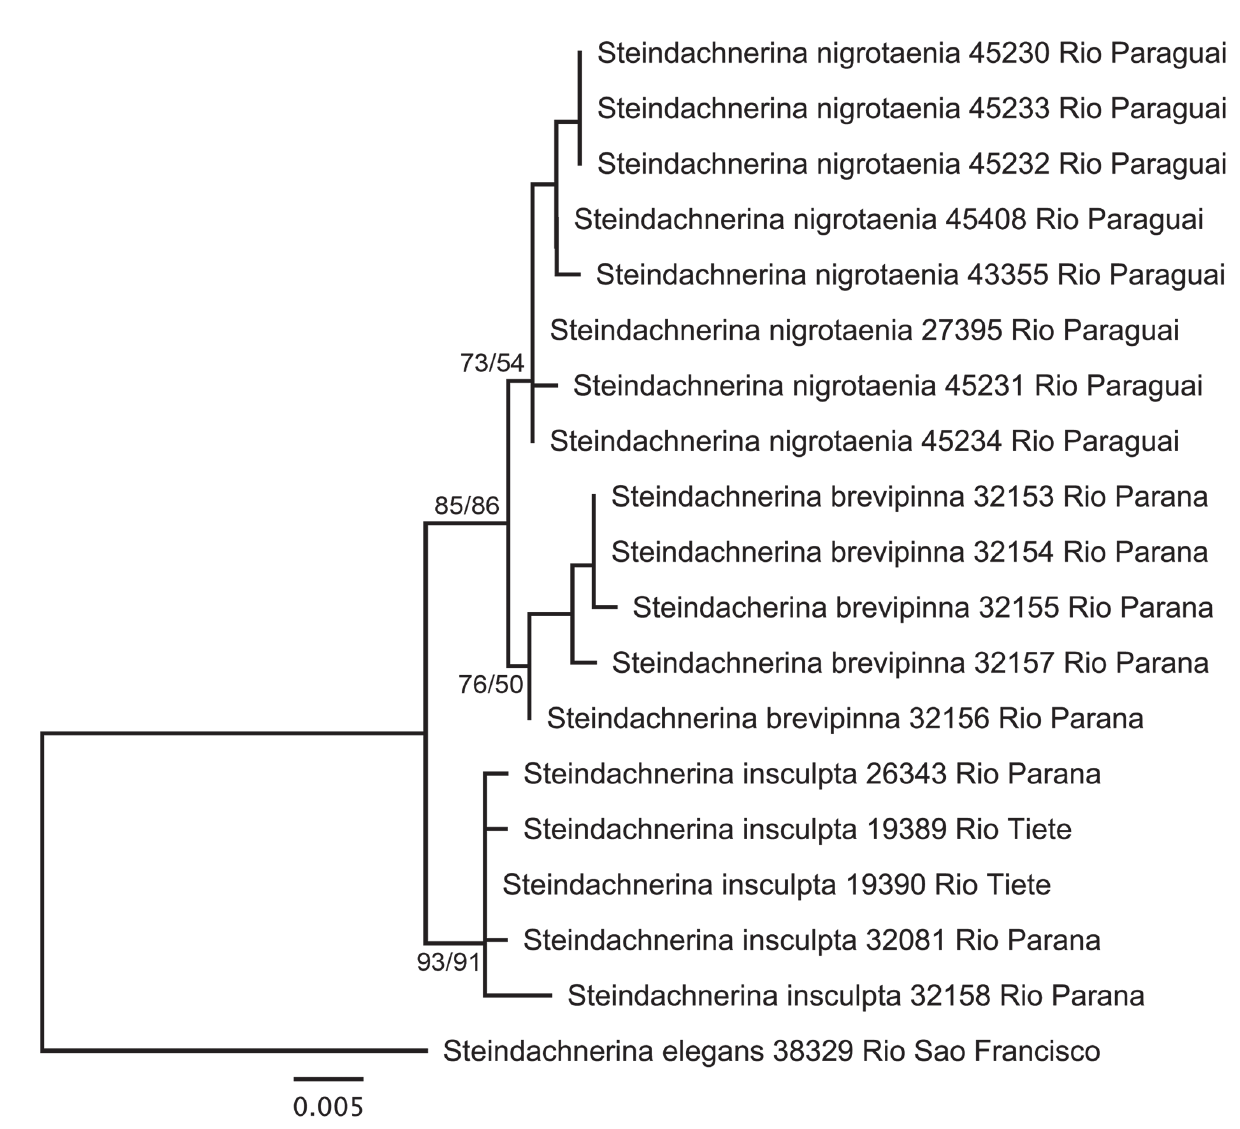
Fig. 1. Best maximum likelihood tree based on partial sequences of the mitochondrial gene cytochrome oxidase c subunit I among samples of Steindachnerina nigrotaenia , S. insculpta and S. brevipinna . Numbers near nodes represent bootstrap values of maximum likelihood/neighbor-joining